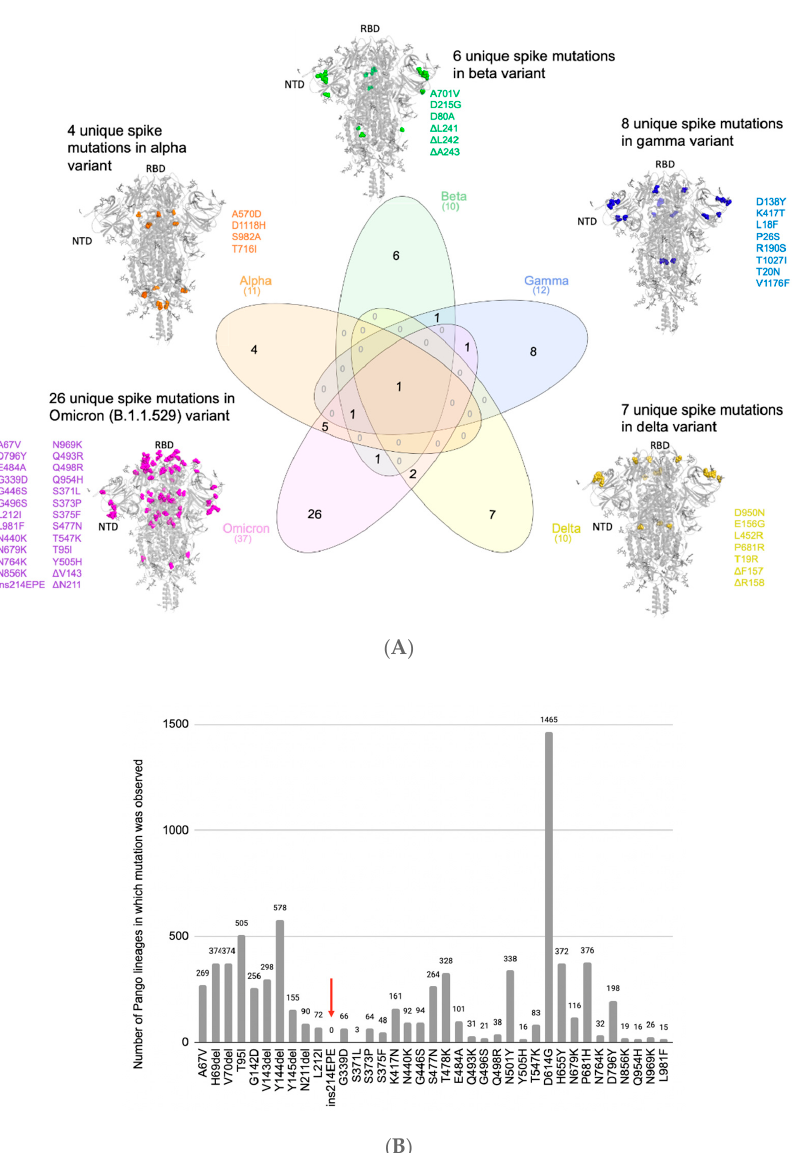
Figure 1. Specificity of Omicron’s Spike mutations relative to SARS-CoV-2 variants of concern and other lineages. ( A ) Comparing the lineage-specific Spike protein mutations in the SARS-CoV-2 variants of concern. The unique mutations observed in the Spike protein for each of the variants are highlighted (spheres) on the homotrimeric Spike protein of SARS-CoV-2. The Omicron (B.1.1.529/BA.1/BA.2) variant has the highest number (26) of unique mutations in the Spike protein from this perspective, making its emergence a “step function” in the evolution of SARS-CoV-2 strains. ( B ) Prevalence of Omicron’s Spike mutations in other SARS-CoV-2 lineages. Bar plot denoting the number of SARS-CoV-2 lineages (besides Omicron) in which the mutations present in Omicron are observed. The red arrow highlights the insEPE214 mutation, which is absent from all other SARS-CoV-2 lineages.